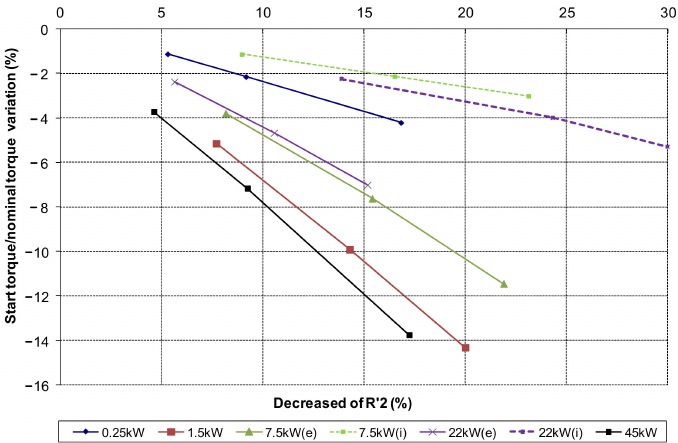
Figure 16. Start torque/nominal torque versus decreased of R (cid:48) 2 in all the motors (in the double cage motors, subscript e for external cage variation and subscript i for internal cage variation is used).